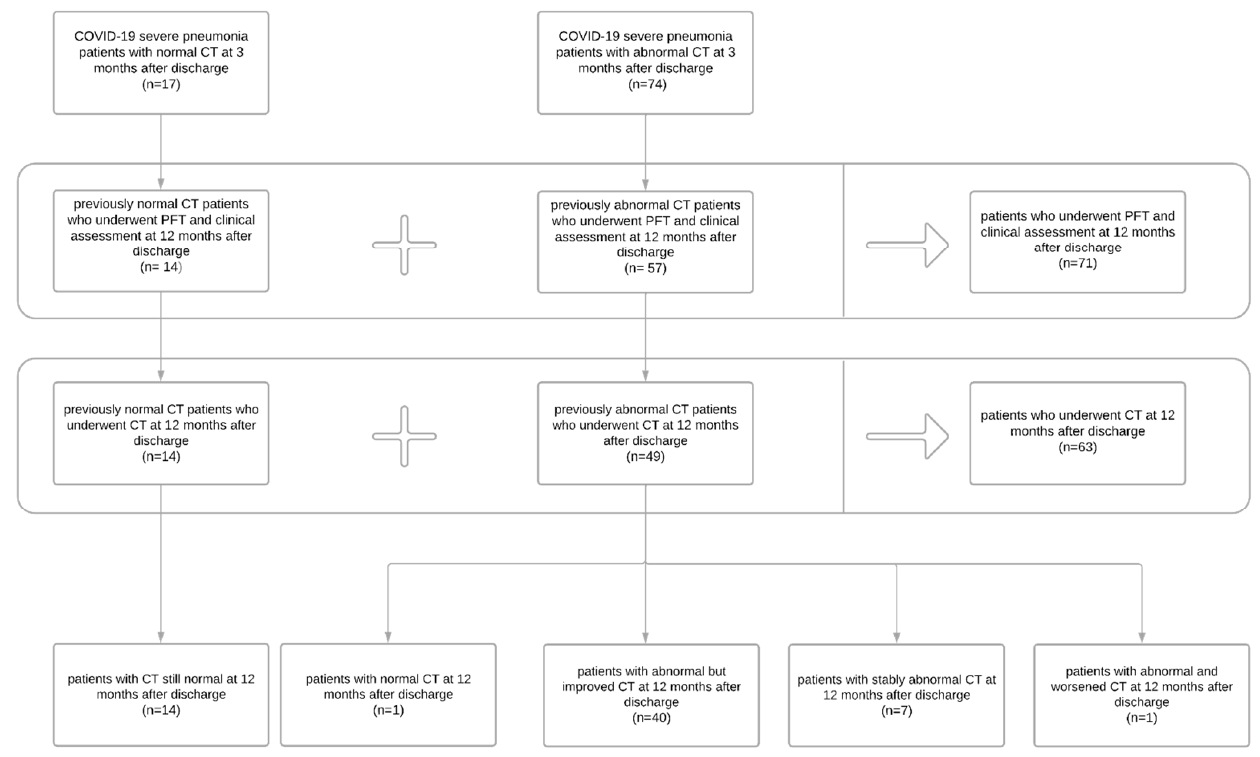
Figure 1. Flow chart of the study participants.